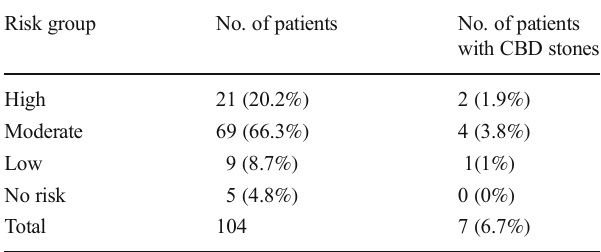
Correlation between risk groups and frequency of CBD lithiasis on preoperative magnetic resonance